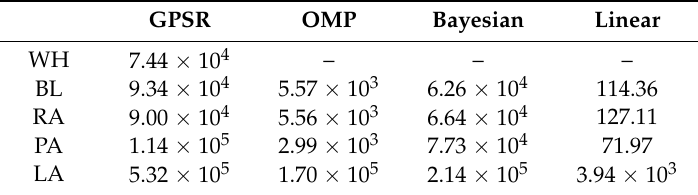
Table 6. Average execution time (ms) of decoder for different measurement structures using different recovery algorithms. GPSR OMP Bayesian WH